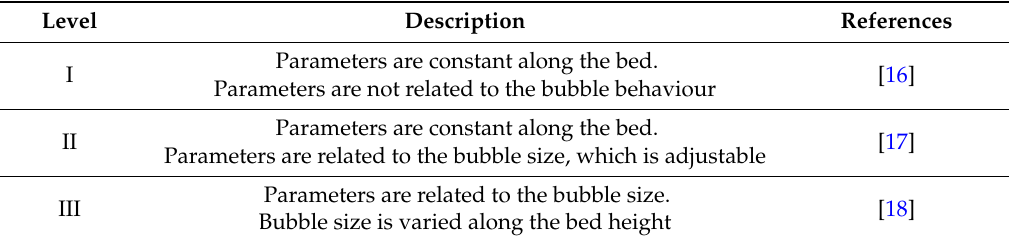
Table 1. Different phenomenological models described in the